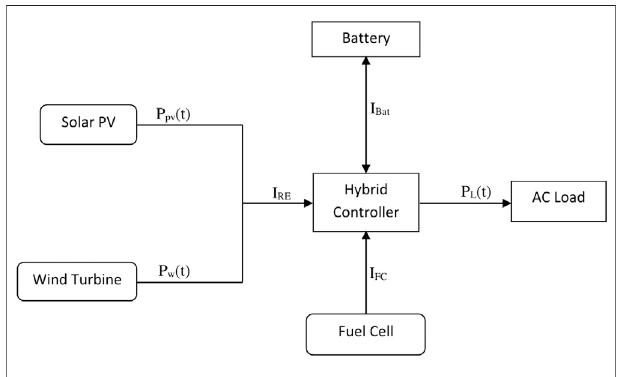
FIGURE 1 | Integrated renewable system